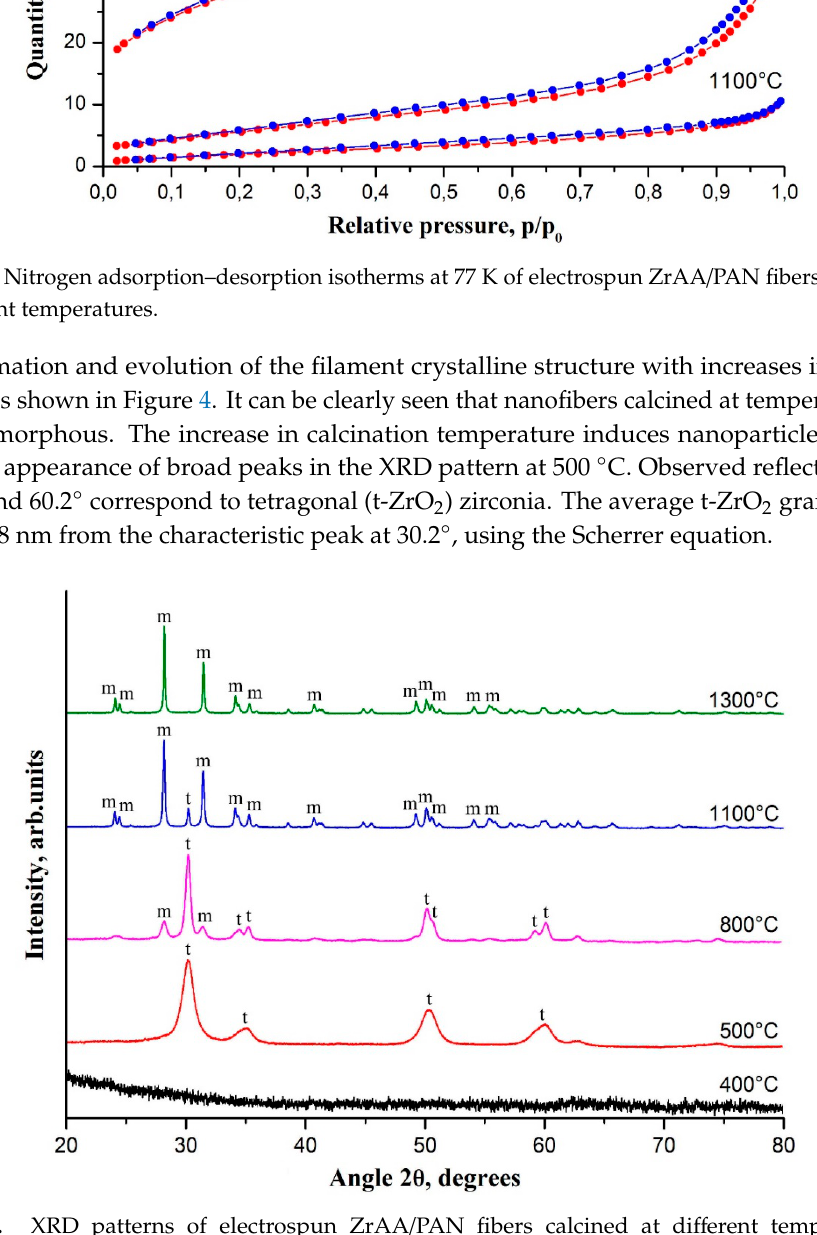
Figure 4. XRD patterns of electrospun ZrAA/PAN fibers calcined at different temperatures. m—monoclinic phase of ZrO 2 , t—tetragonal phase of ZrO 2 .